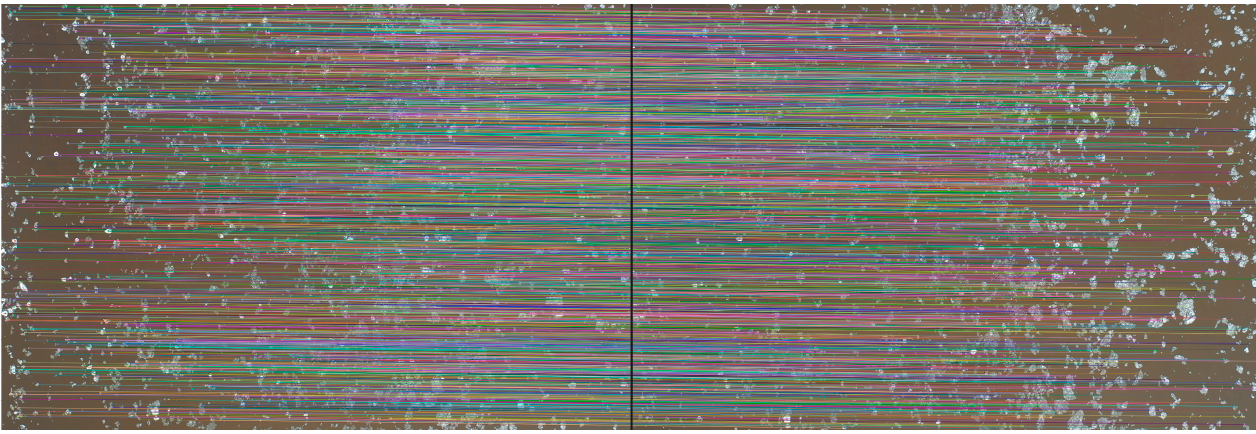
Figure 3. Distribution of feature point pairs at 16:00 on 25 April 2021.